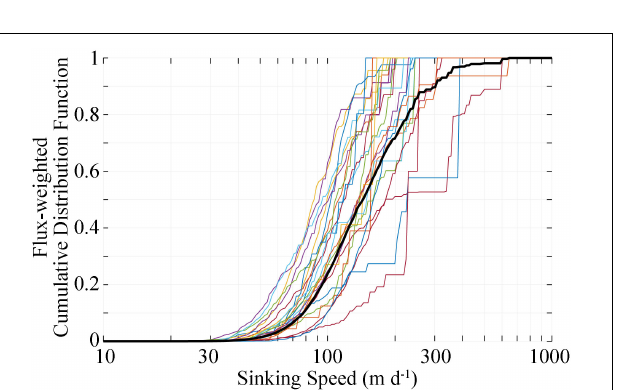
FIGURE 7 | Flux weighted cumulative distribution function for fecal pellets with different sinking speeds. Fecal pellet sinking speeds were calculated from morphometric measurements of fecal pellets collected in sediment traps and Eq. 3. Colored lines are results from individual samples. Black line is the flux-weighted mean of all